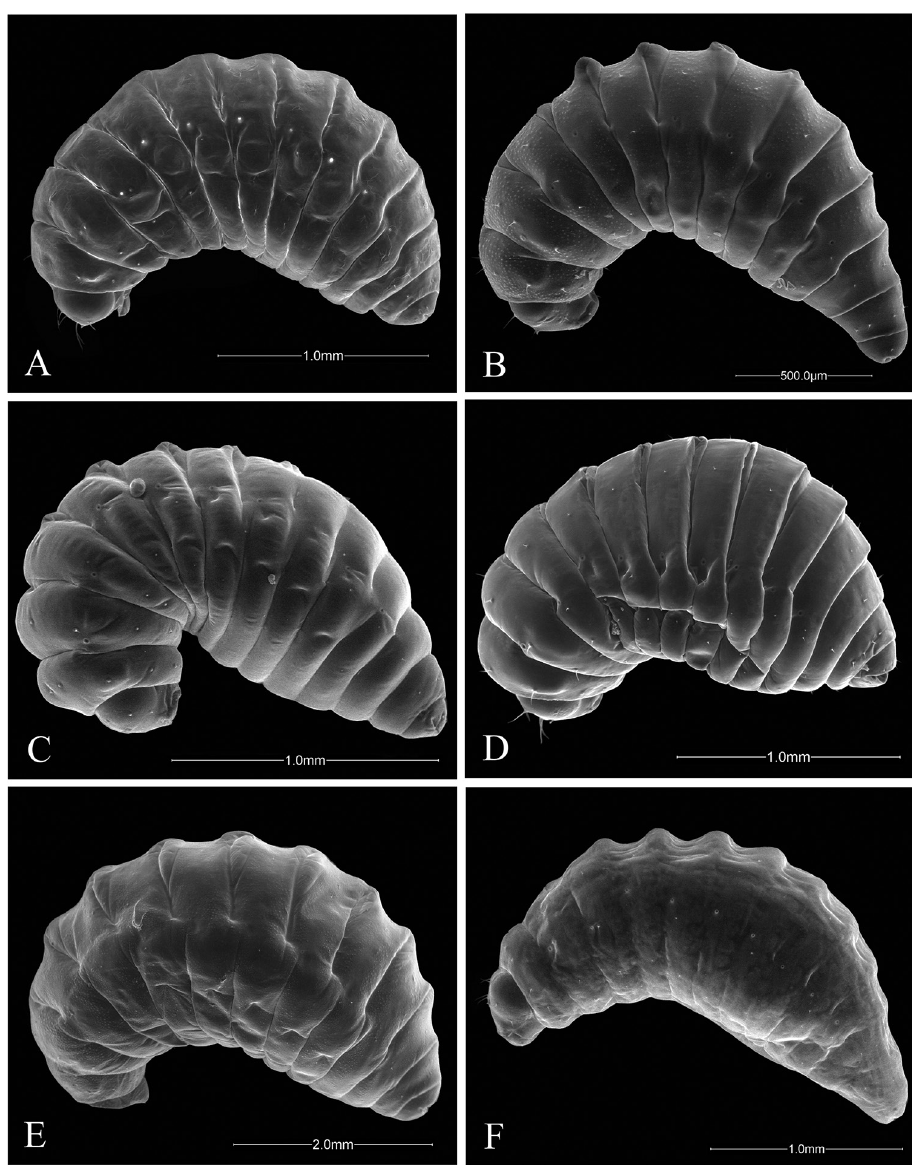
Figure 5. Lateral views of Ormyrus terminal-instar larvae. A Ormyrus capsalis B O. cupreus C O. diffinis D O. gratiosus E O. nitidulus F O. papaveris